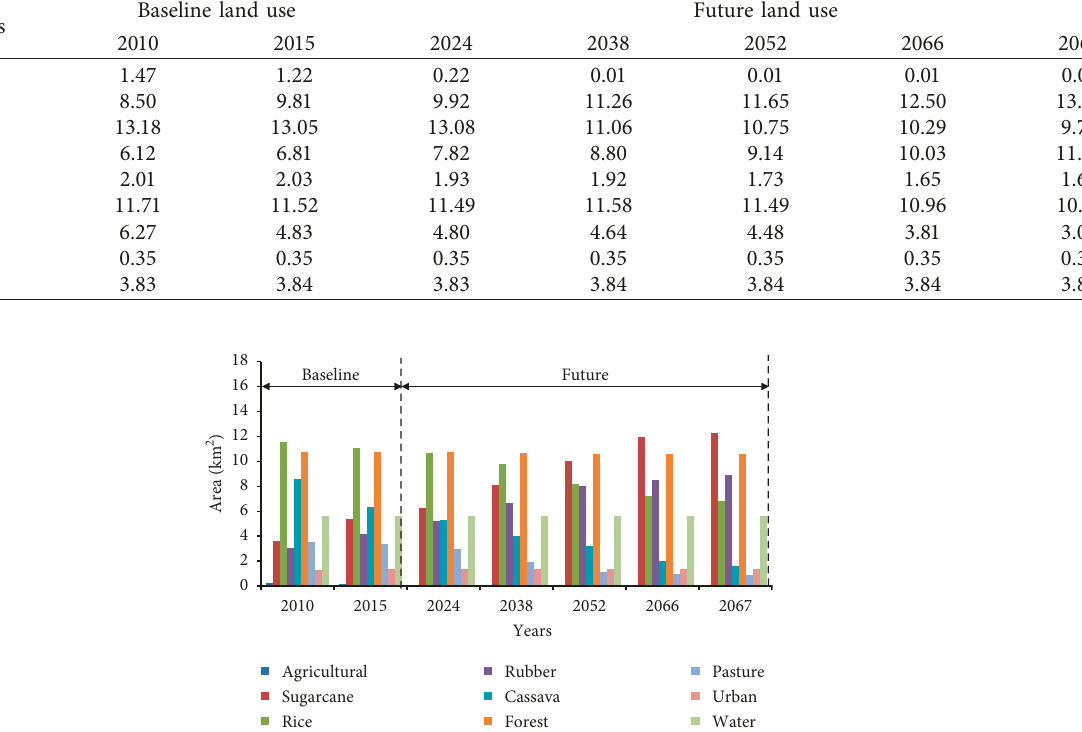
Table 9: Trends of land use change for baseline and future periods above the Huay Ling Jone area (km 2 ) by participation process.